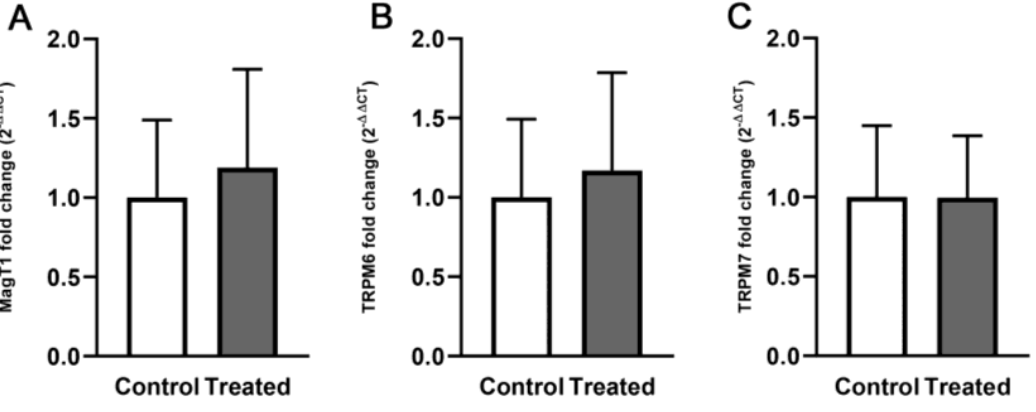
Figure 3. Relative expression of Mg transporters mRNA levels. mRNA was extracted from kidney tissue of mice fed either a normal (control) or a Mg deficient diet (treated) for eight weeks, retro transcribed and amplified by q-PCR. Data (n = 7 for each group) are presented as a bar graph. The relative fold change of MagT1 ( A ), TRPM6 ( B ) and TRPM7 ( C ) mRNA of treated samples vs. controls has been calculated via the 2 − ∆∆ Ct method. GAPDH was used as housekeeping gene; Ct = threshold cycle, ∆ Ct = normalized Ct = Ct( Target ) − Ct( GAPDH ) and ∆∆ Ct = ∆ Ct Target (treated sample) − ∆ Ct Target (control